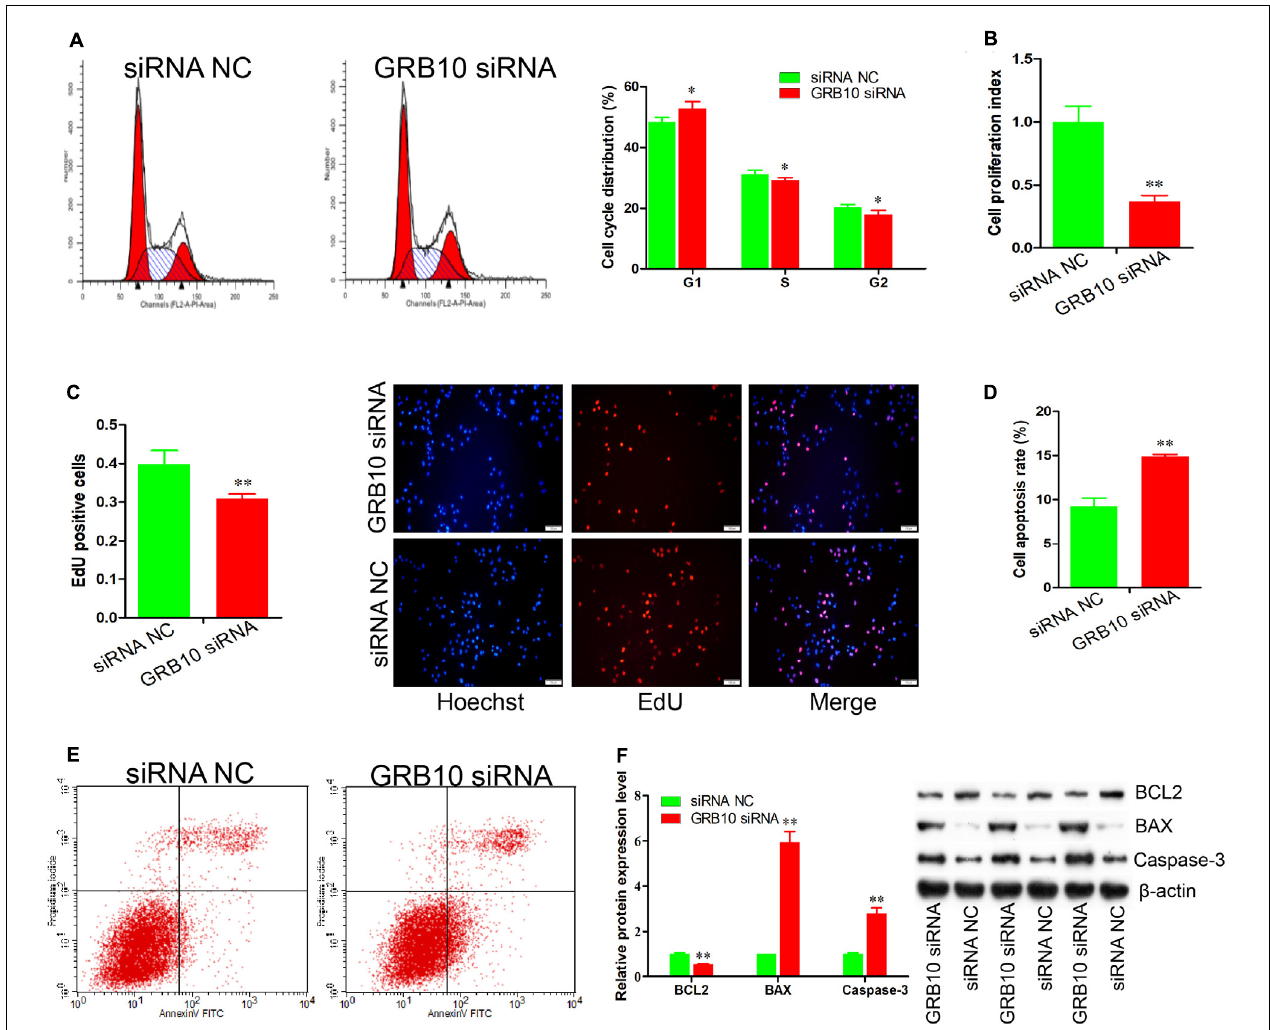
FIGURE 4 | GRB10 deficiency inhibits proliferation and induces apoptosis in immature porcine Sertoli cells. (A) The cell cycle was analyzed using a FACSCanto II flow cytometer, and its distribution was calculated ( n = 3). (B,C) The effects of GRB10 inhibition on cell proliferation was detected using CCK-8 (B) and EdU corporation (C) assays ( n = 3). Scale bar = 100 µ m. (D,E) The cell apoptosis rate was measured using the Annexin V-FITC/PI staining assay ( n = 3). (F) The protein expression of cell survival-related genes was measured using western blot assay. The β -actin gene was used as the internal control. Data are presented as mean ± S.D. ∗ P < 0.05 and ∗∗ P <